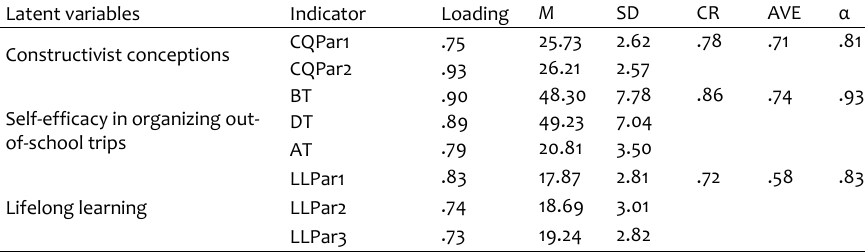
Table 3. Correlations between the